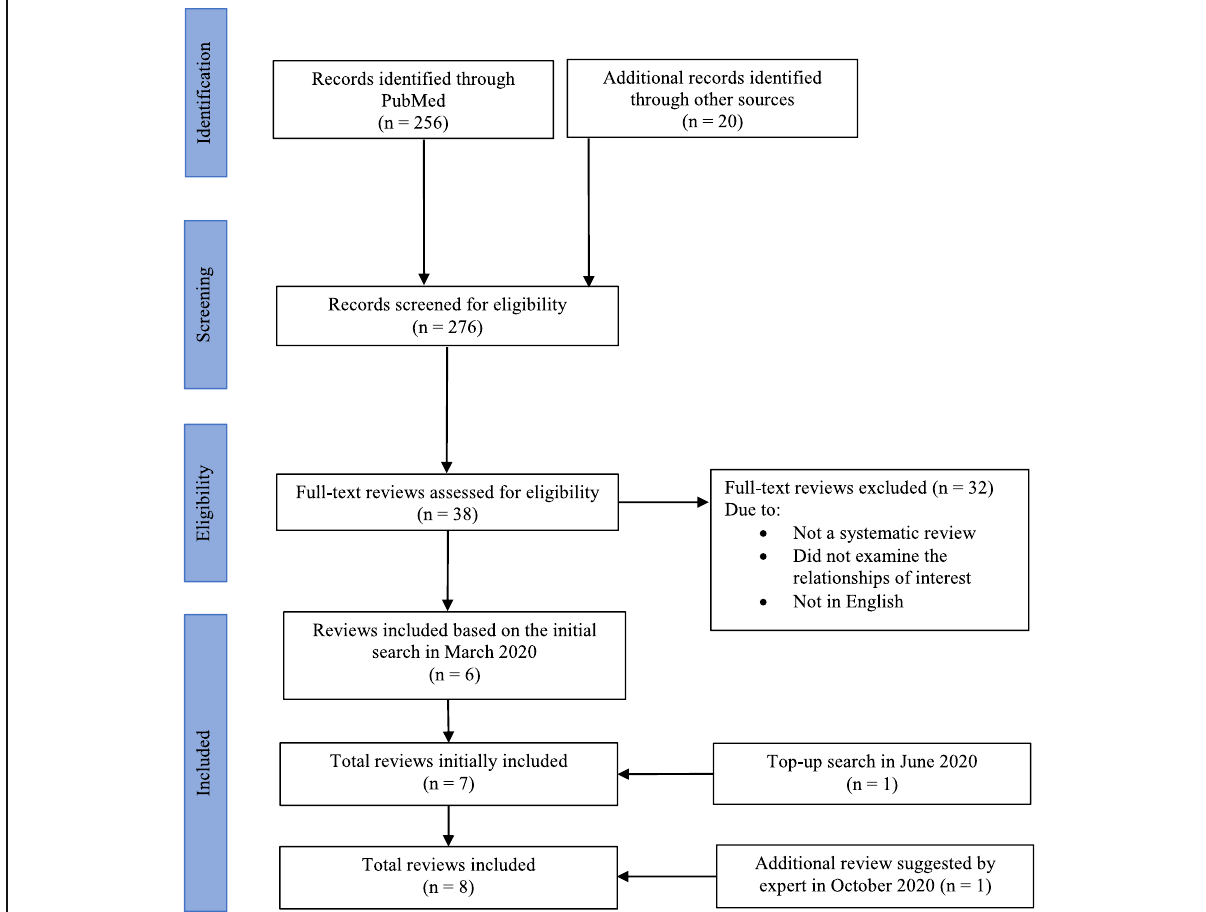
Fig. 1 PRISMA flow diagram of the literature reviewing